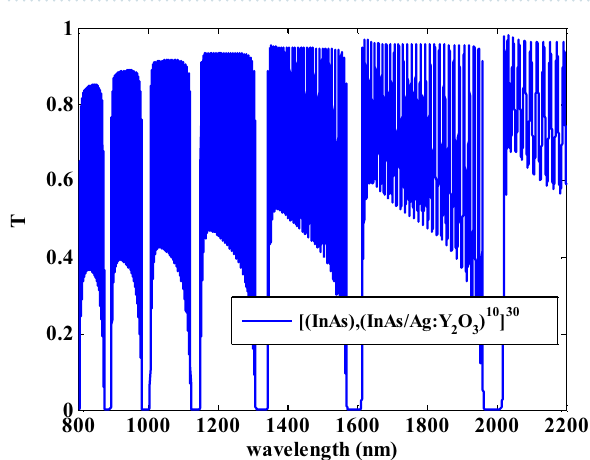
Figure 5. The transmittance characteristics of the proposed one-dimensional photonic crystal design containing HMM at different S (periodicity of HMM).